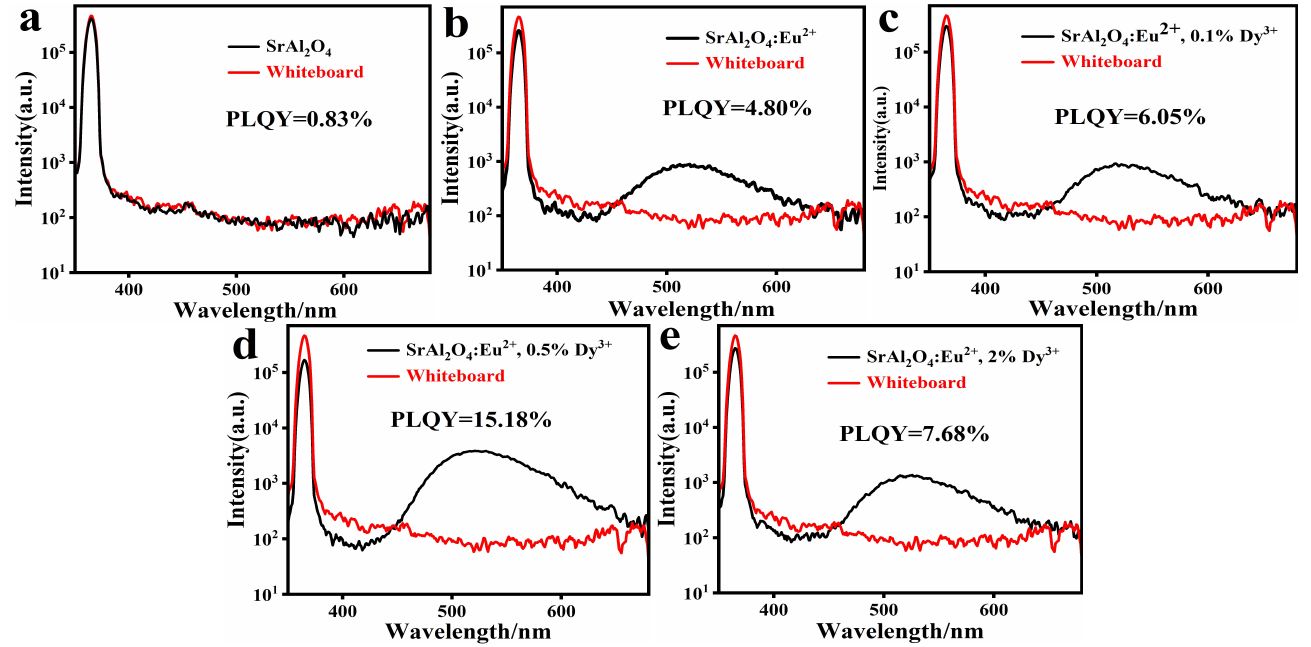
Figure 14. Fluorescence spectra of different samples and quantum yield ( a ) SrAl 2 O 4 , ( b ) SrAl 2 O 4 : Eu 2+ , ( c ) SrAl 2 O 4 : Eu 2+ , 0.1 %Dy 3+ , ( d ) SrAl 2 O 4 : Eu 2+ , 0.5 %Dy 3+ , and ( e ) SrAl 2 O 4 : Eu 2+ , 2%Dy 3+ .